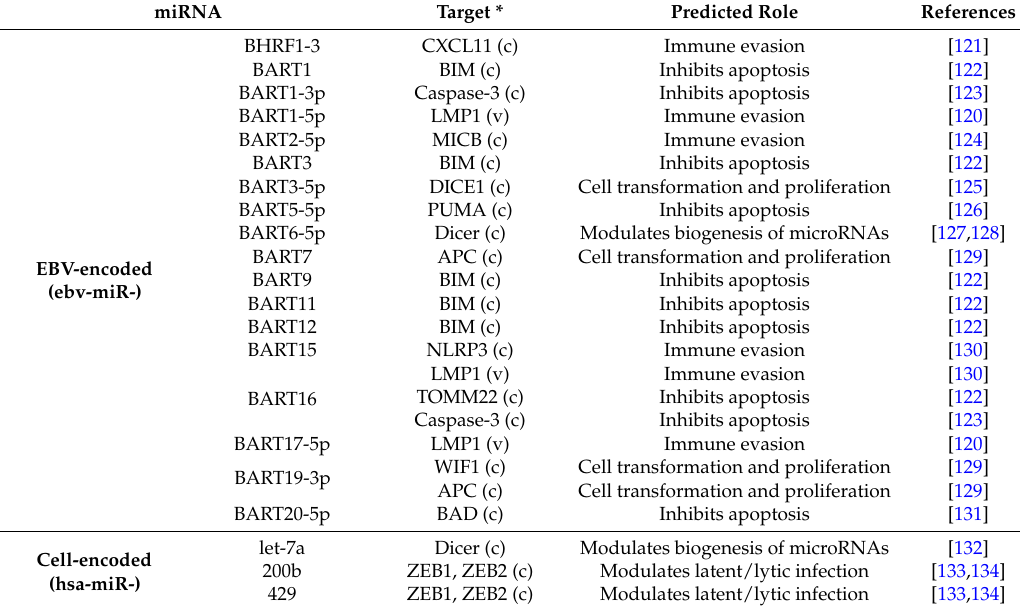
Table 1. MicroRNAs (EBV- or cell-encoded) with potential role in EBV infection and pathogenesis. miRNA Target * Predicted